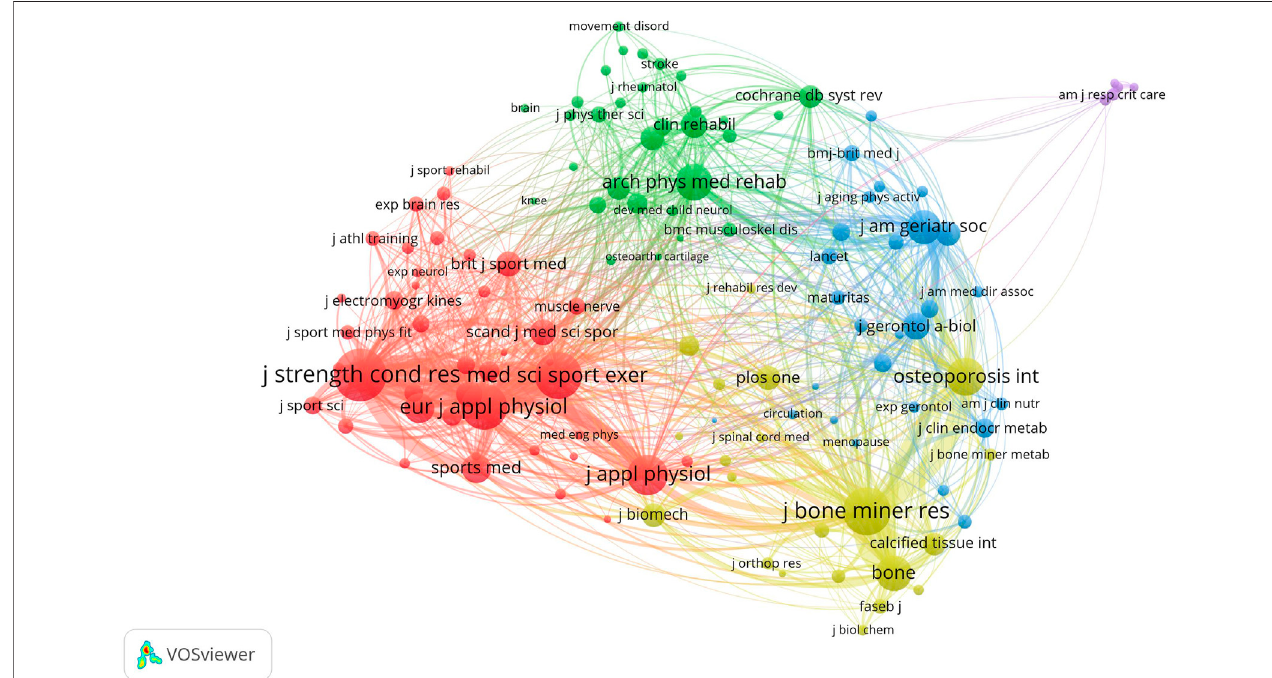
FIGURE 5 | Co-citation network of productive journals in the research of WBVT.